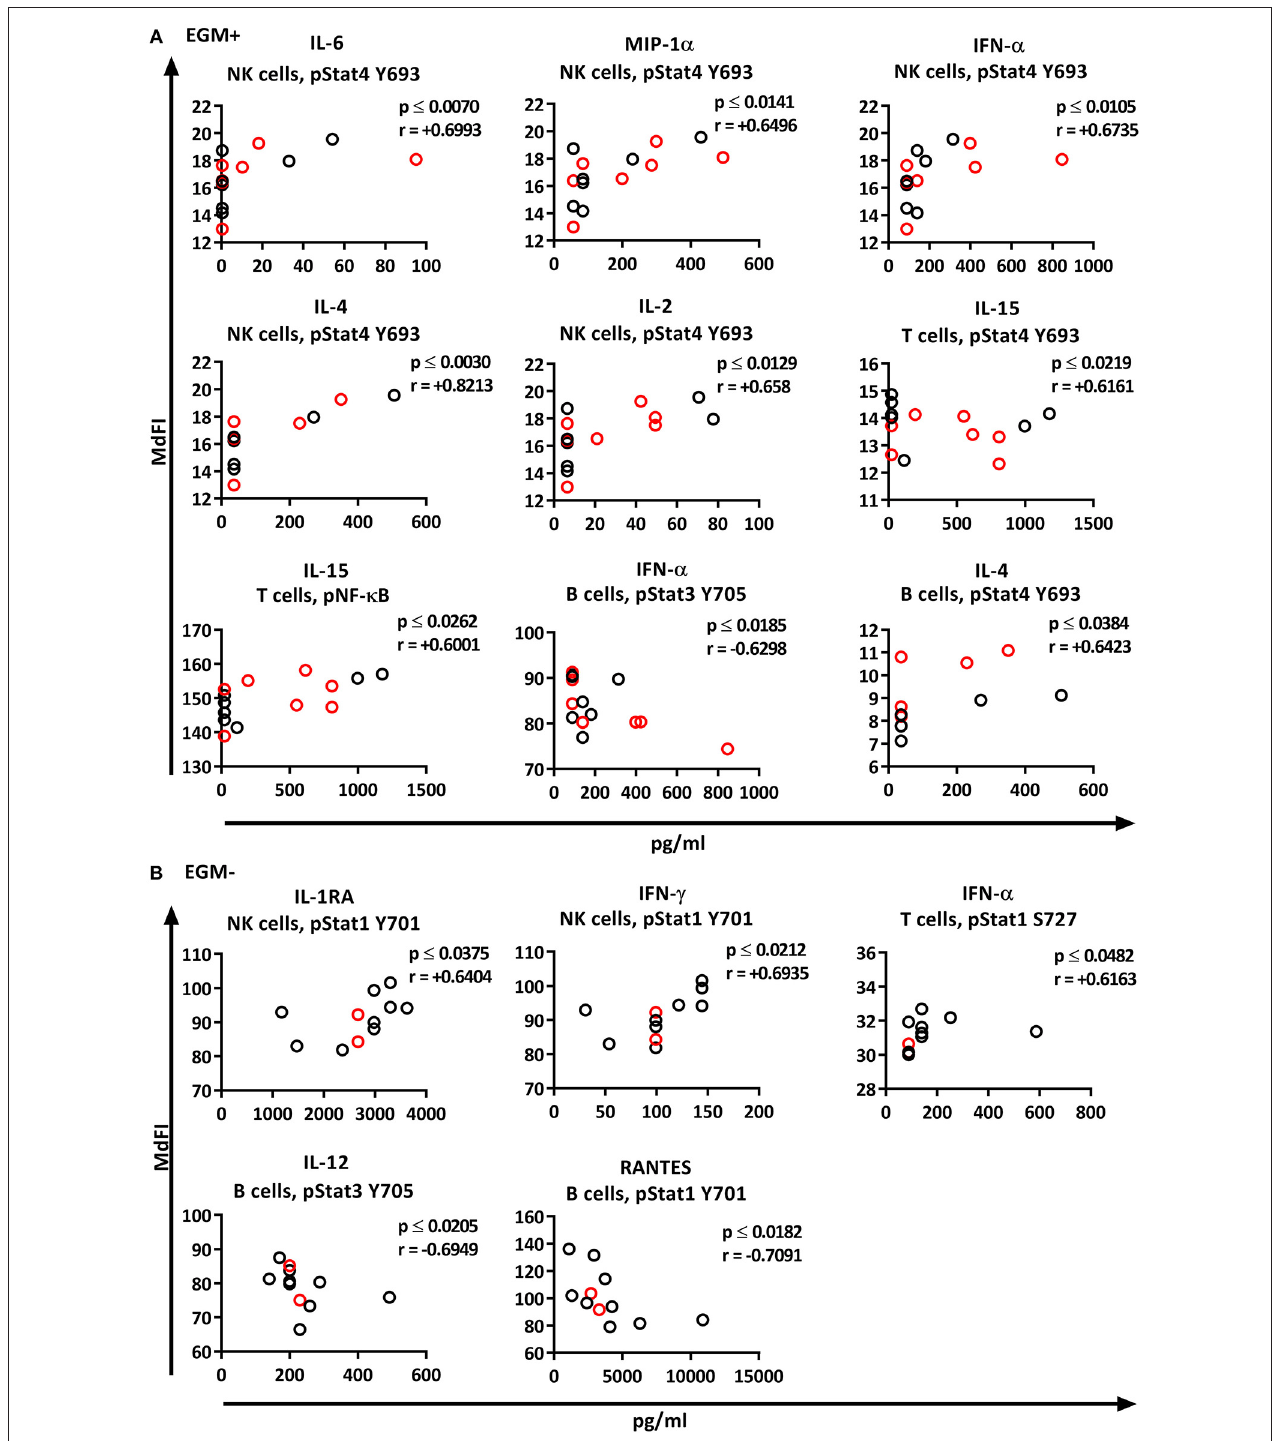
FIGURE 9 | Correlation of basal phosphorylation profiles with plasma cytokine levels in pSS patients grouped according to the presence of extraglandular manifestations (EGM). Extraglandular manifestation positive pSS patients (EGM + ) (A) and extraglandular manifestation negative pSS patients (EGM–) (B) . Correlations were assessed by Spearman’s rank test. Medicated patients are shown in red while un-medicated patients are shown in black. Strong ( r = 0.6–0.79) to very strong ( r = 0.8–1.0) associations are shown with respective p and r -values given at the side of each graph. Associations were considered statistically significant for p ≤ 0.05. X-axis denotes concentration of cytokines (pg/ml) and Y-axis denotes phosphorylation levels (MdFI). The data represents pSS patients ( n = 25) grouped into EGM + patients ( n = 14) (except for IL-4, n = 11) and EGM– patients ( n = 11).